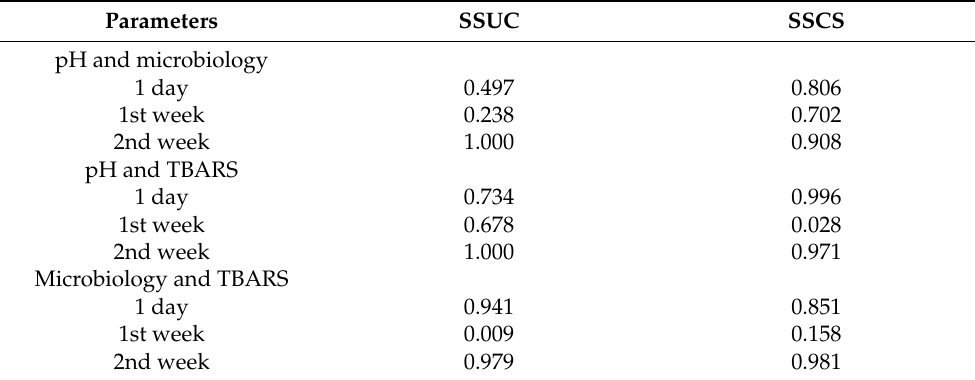
Table 6. RSQ among Longissimus dorsi muscle’s pH, microbiology, and oxidative stability (TBARS value) in Korean Hanwoo Finishing Cattle.